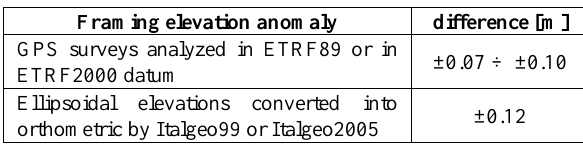
Table 1. Theoretical values of systematic